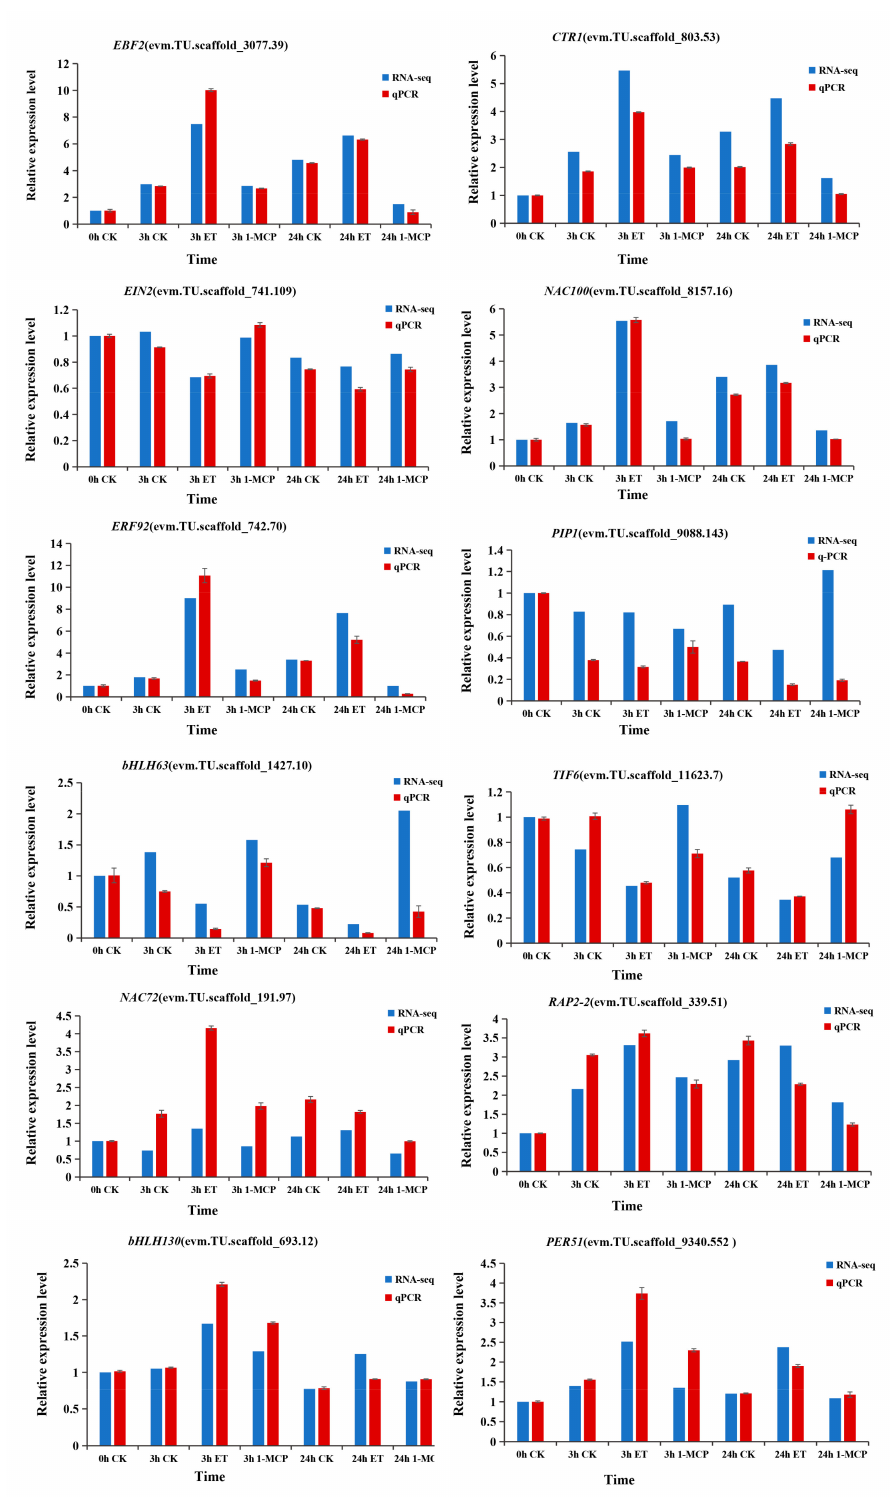
Figure 6. Quantitative reverse transcription PCR validation and RNA-seq data of selected DEGs in cut chrysanthemum ‘FenDante’. DEGs, differentially expressed